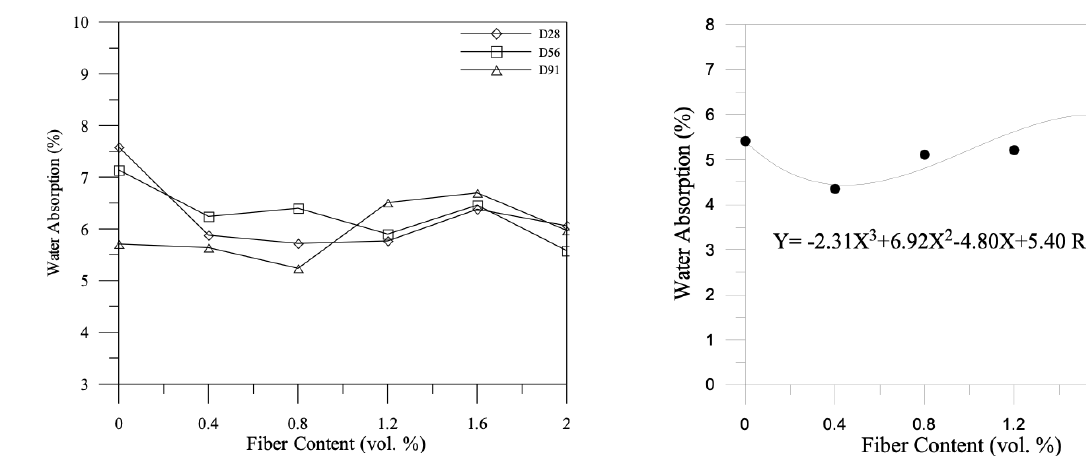
Figure 5. Relationship between absorption and fiber comtent (40% slag).